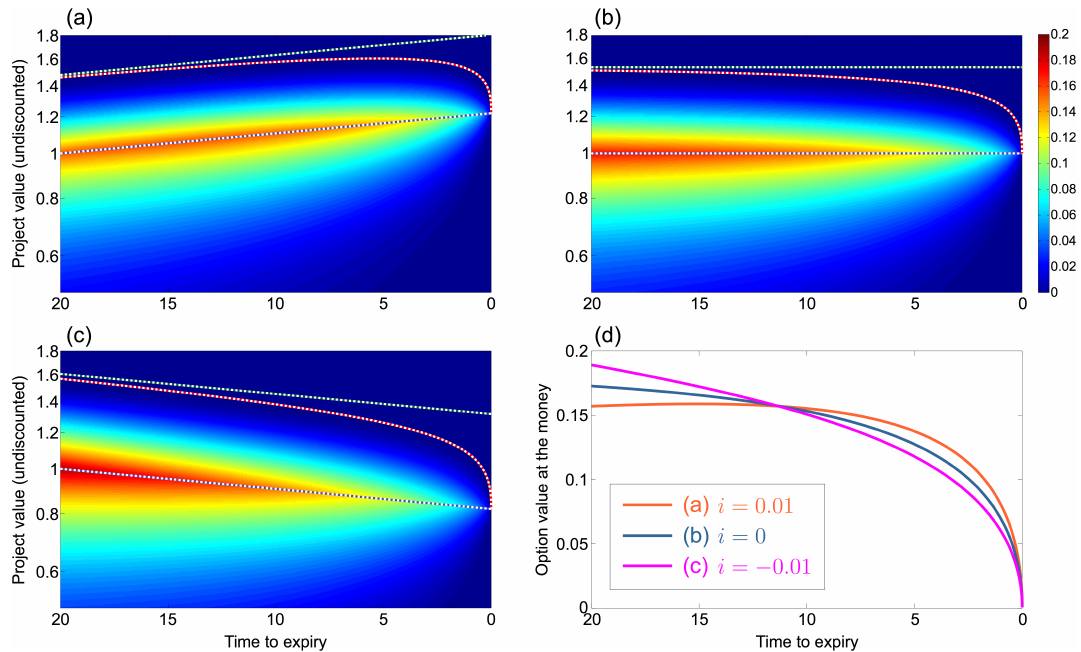
Figure 3. ( a ) Case T = 20, α = i = 0.01. Colour scale represents the undiscounted time value of the real option. The vertical axis (undiscounted project value) is plotted with a logarithmic scale, and the horizontal axis represents time. Blue line: at the money; Red line: exercise threshold; Green line: Infinite-maturity exercise threshold. ( b ) Case T = 20, α = i = 0. ( c ) Case T = 20, α = i = − 0.01.; ( d ) Plot of undiscounted option value at the money, versus time to expiry, for the three cases represented in ( a – c ). Exercise threshold at t = 0: ( a ) 1.4593; ( b ) 1.5102; ( c ) 1.5652. Option value at the money ( t = 0): ( a ) 0.1570; ( b ) 0.1727; ( c ) 0.1892. Calculation times (backwards induction step): ( a ) 3.26 s; ( b ) 3.19 s; ( c ) 3.61